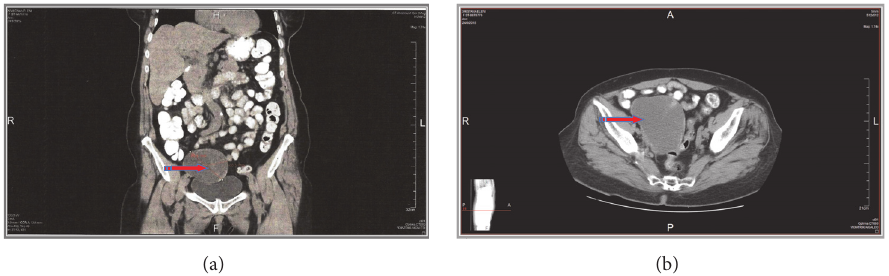
Figure 2: Abdominal CT revealed a cyst sized 100 × 80 mm with signs of calcification in the area of the right ovary (arrows).